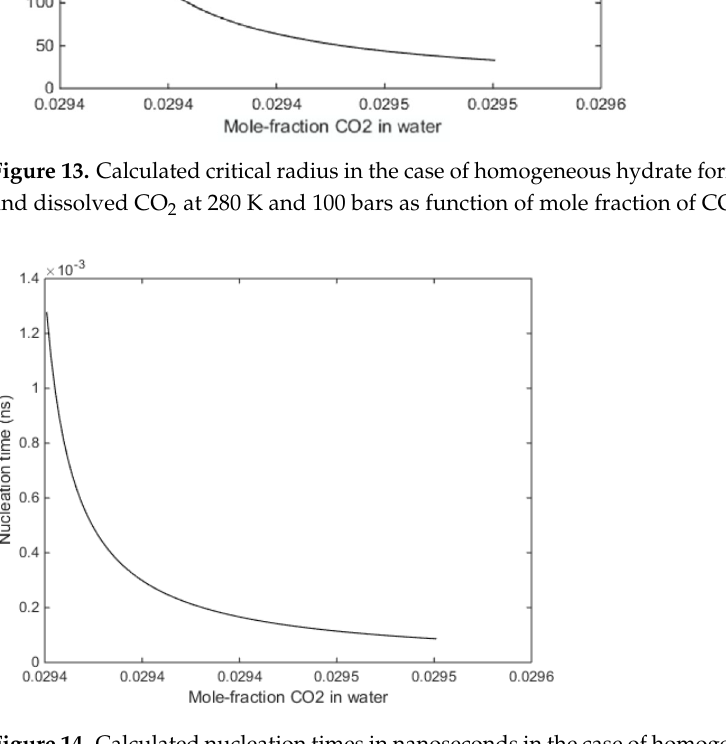
Figure 14. Calculated nucleation times in nanoseconds in the case of homogeneous hydrate for- mation from liquid water and CO 2 dissolved in water at 280 K and 100 bars.